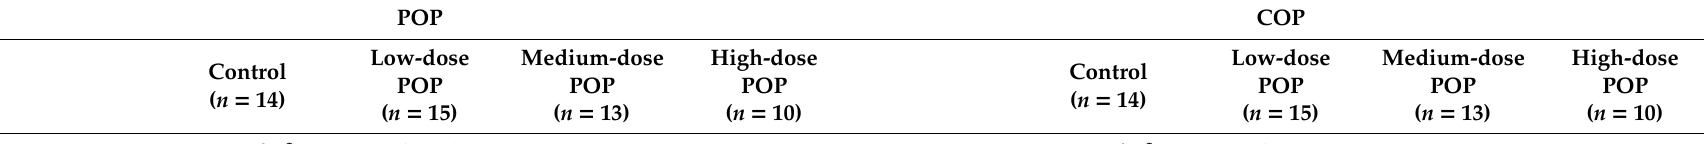
Table 3. Absolute baseline and stabilized concentrations a and total cholesterol-standardized concentrations of total and individual POP (plant sterol oxidation products) and COP (cholesterol oxidation products) during a six-week dietary intake of increasing doses of POP (PP2 study